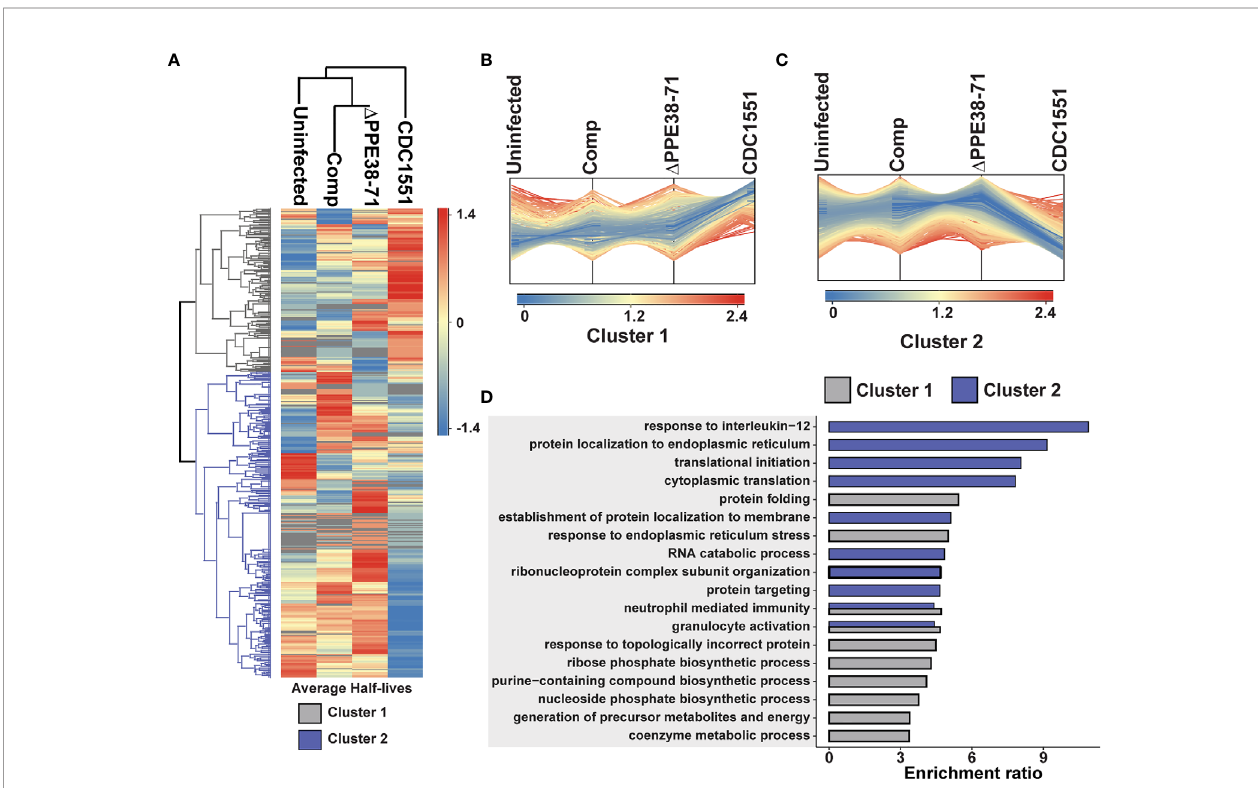
FIGURE 3 | Infection with M. tuberculosis CDC1551 and not M tuberculosis D ppe38-71 causes a shift in protein turnover associated with the IL-12 pro- in fl ammatory pathway. (A) Half-lives from THP-1 macrophage-like cells infected with M. tuberculosis CDC1551, M. tuberculosis D ppe38-71 and the complemented strain and uninfected control macrophages were assessed using hierarchical clustering with Euclidean distance. Two distinct clusters formed representing either an increase (cluster 1) or a decrease (cluster 2) in protein half-lives as depicted by pro fi le plots. Protein groups from (B) cluster 1 and (C) cluster 2 are represented as a deviation in the estimated marginal mean of each protein half-life, after adjustment of covariates, across each factor. (D) GO enrichment analysis of each cluster obtained in A and B. Protein turnover data is representative of two biological